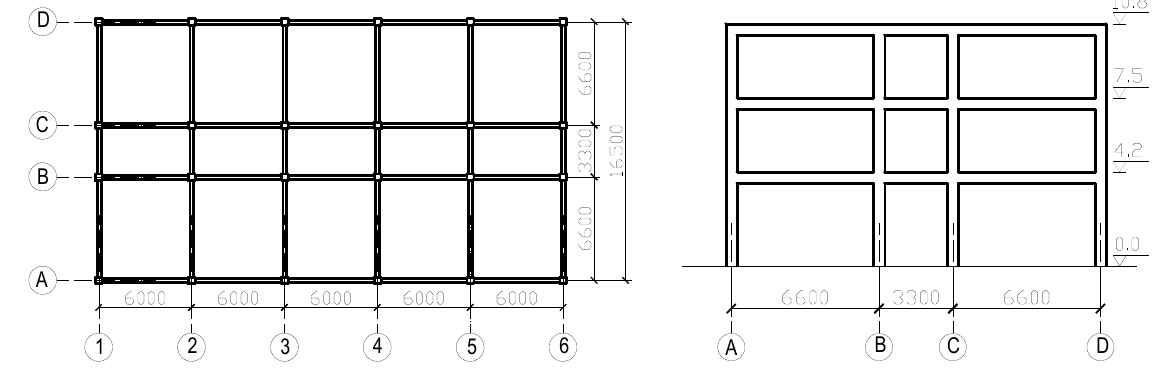
Figure 4. Elevation of the RC frame structures (Unit: mm) (3-story frame as an example and other frames having same configuration but different numbers of stories).